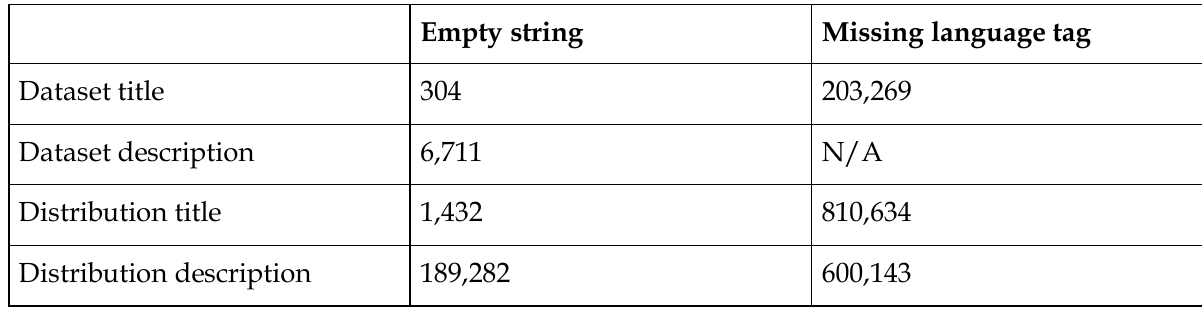
Table 2: Missing language tags and empty texts